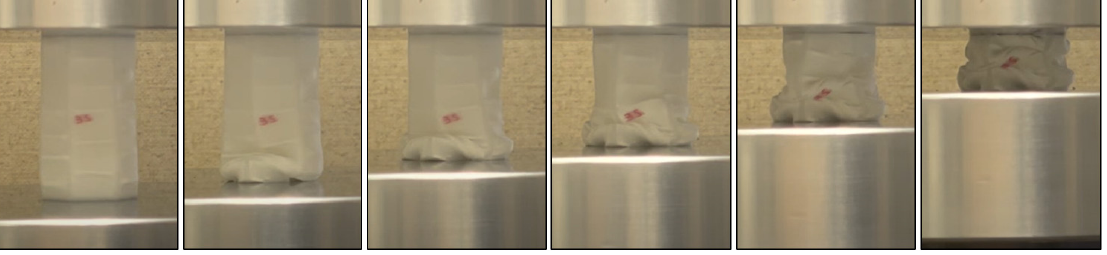
Figure 17. Experimental compression test of standard hexagonal cell under axial load.